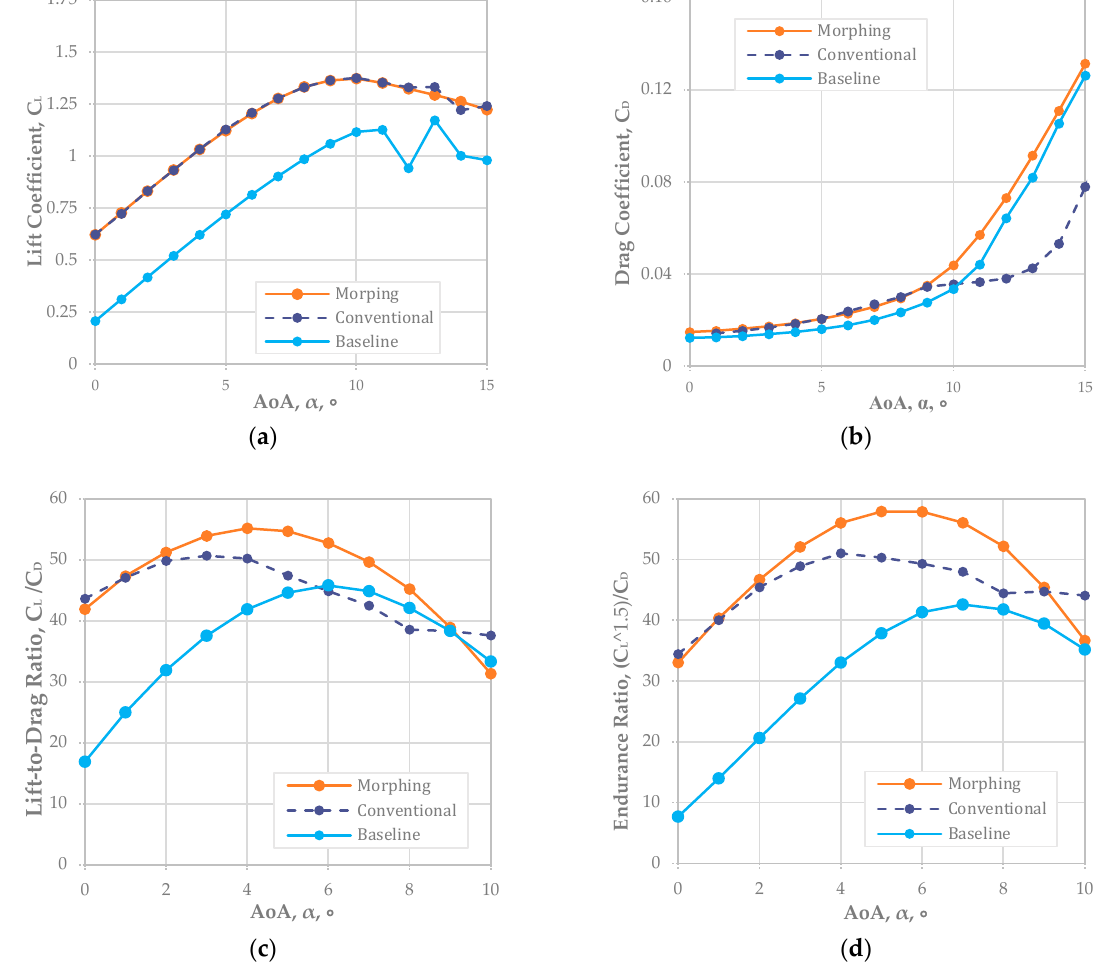
Figure 4. Matching C L morphing (NACA 6410) and conventional airfoil plots (Re = 778,179): ( a ) C L ; Figure 4. Matching 𝐶 (cid:3013) morphing (NACA 6410) and conventional airfoil plots (Re = 778,179): ( a ) 𝐶 (cid:3013) ; ( b ) 𝐶 (cid:3005) ; ( c ) 𝐶 (cid:3013) 𝐶 (cid:3005) ⁄ ; ( d ) endurance ratio. ( b ) C D ; ( c ) C L / C D ; ( d ) endurance